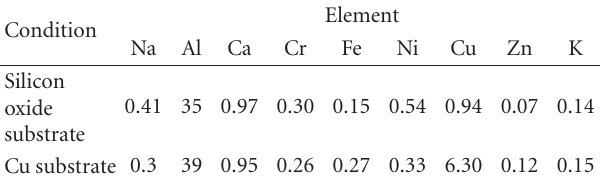
Table 2: Metal concentration of chamber shower head after numer- ous silicon nitride depositions on silicon oxide and Cu